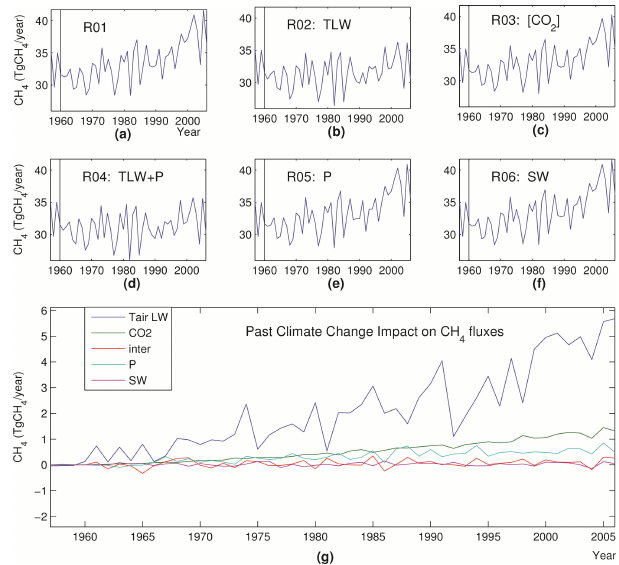
Figure 5. Time series of domain-averaged annual methane fluxes from (a) the historical simulation; (b–f) the five climate control runs, in each of which one climate driver was detrended starting in 1960; (g) differences between historical simulation in (a) and the control runs (b–f) . “TLW” and “Tair LW” denote detrending of air temperature and associated downward longwave radiation; “CO 2 ” denotes detrending of atmospheric CO 2 concentrations; “TLW + P” denotes detrending of both air temperature (and associated long- wave radiation) and precipitation; “ P ” denotes detrending of pre- cipitation; “SW” denotes detrending of downward shortwave ra- diation; and “inter” denotes the difference between “TLW” and “TLW +